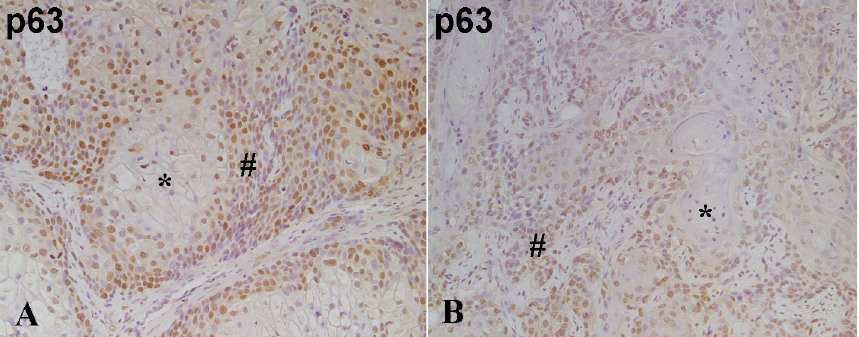
Fig 6. Immuno-histochemical staining for p63 in tumor transplants generated from the As 3+ and Cd 2+ -transformed line. (A). As#2. There is moderate nuclearstaining for p63 in the less differentiated peripheraltumor cells (#) whereasthe well-differentiatedcells ( � ) in the center of the tumornests show no staining.(B). Cd#3. There is moderate nuclearstaining for p63 in the less differentiated peripheraltumor cells (#) whereasthe well-differentiated cells ( � ) in the center of the tumor nests show weak or no staining. The brown color indicates the presence of the proteinwhereas the blue/purplecolor indicates the nucleithat are stained with the counterstainhematoxylin. Allimages are at a magnification of 200X.